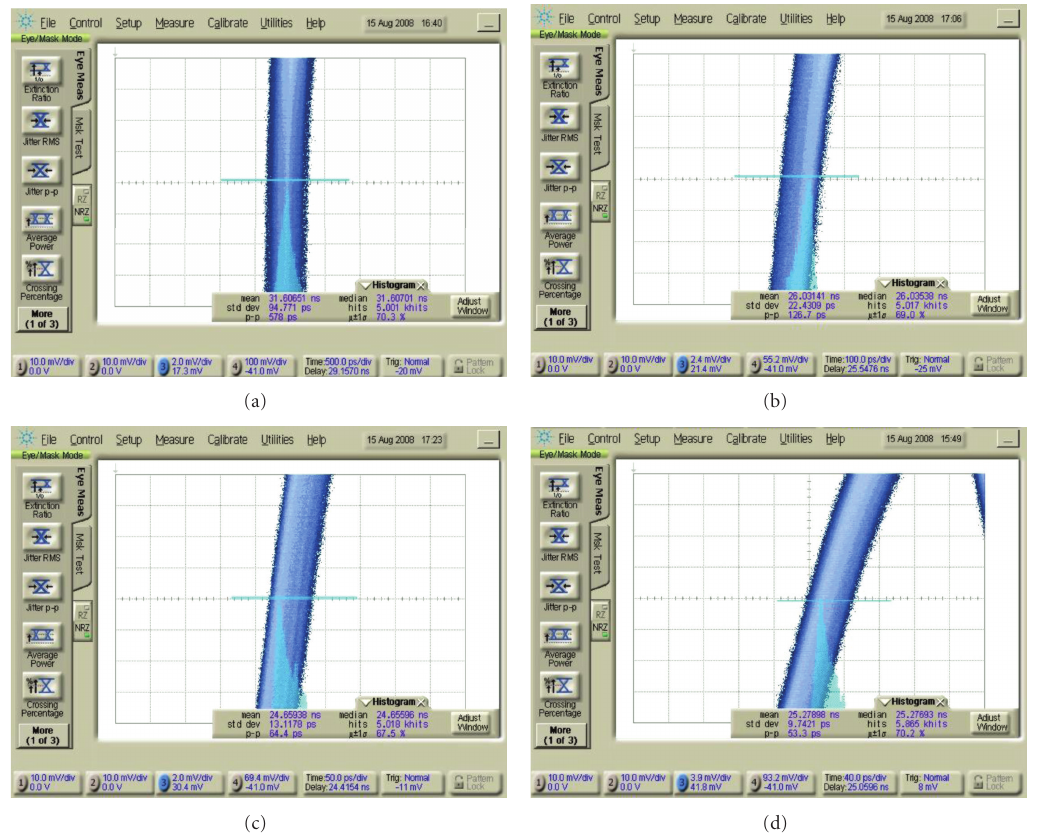
Figure 9: Measured clock jitter @650 Mb/s (a), 3Gb/s (b), 6Gb/s(c) and 8 Gb/s